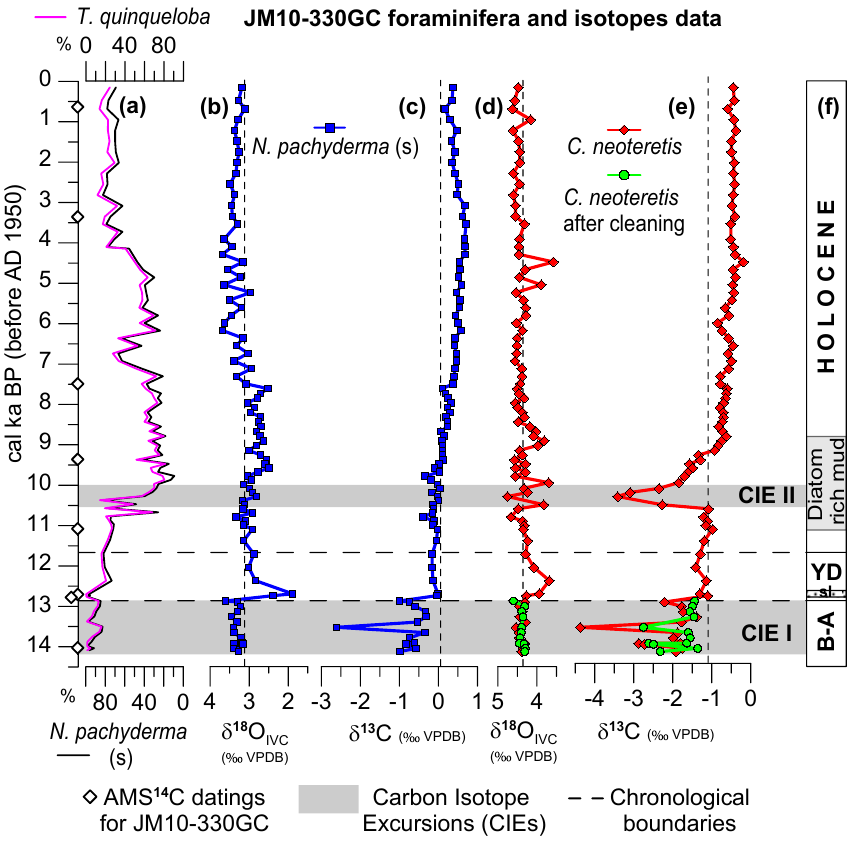
Figure 4. Planktonic foraminifera and geochemical data of core JM10-330GC plotted versus calibrated (cal) ka before present (BP; before AD1950): (a) relative abundance of Neogloboquadrina pachyderma (s) (black line) and Turborotalita quinqueloba (purple line), (b) ice- volume-corrected (IVC) δ 18 O IVC record of N. pachyderma (s), (c) δ 13 C record of N. pachyderma (s), (d) δ 18 O IVC record of Cassidulina neoteretis before (red line) and after (green line) the cleaning protocol of Pena et al. (2005), (e) δ 13 C record of C. neoteretis before (red line) and after (green line) the cleaning protocol of Pena et al. (2005), and (f) stratigraphy obtained for JM10-330GC with chronological subdivisions (dashed lines). Dotted vertical lines indicate average core values. White diamonds on the y axis indicate AMS 14 C dating points for JM10-330GC. Shaded horizontal bars indicate carbon isotope excursion (CIE) I and II. Abbreviations: B-A, Bølling–Allerød; YD, Younger Dryas; sl, sandy